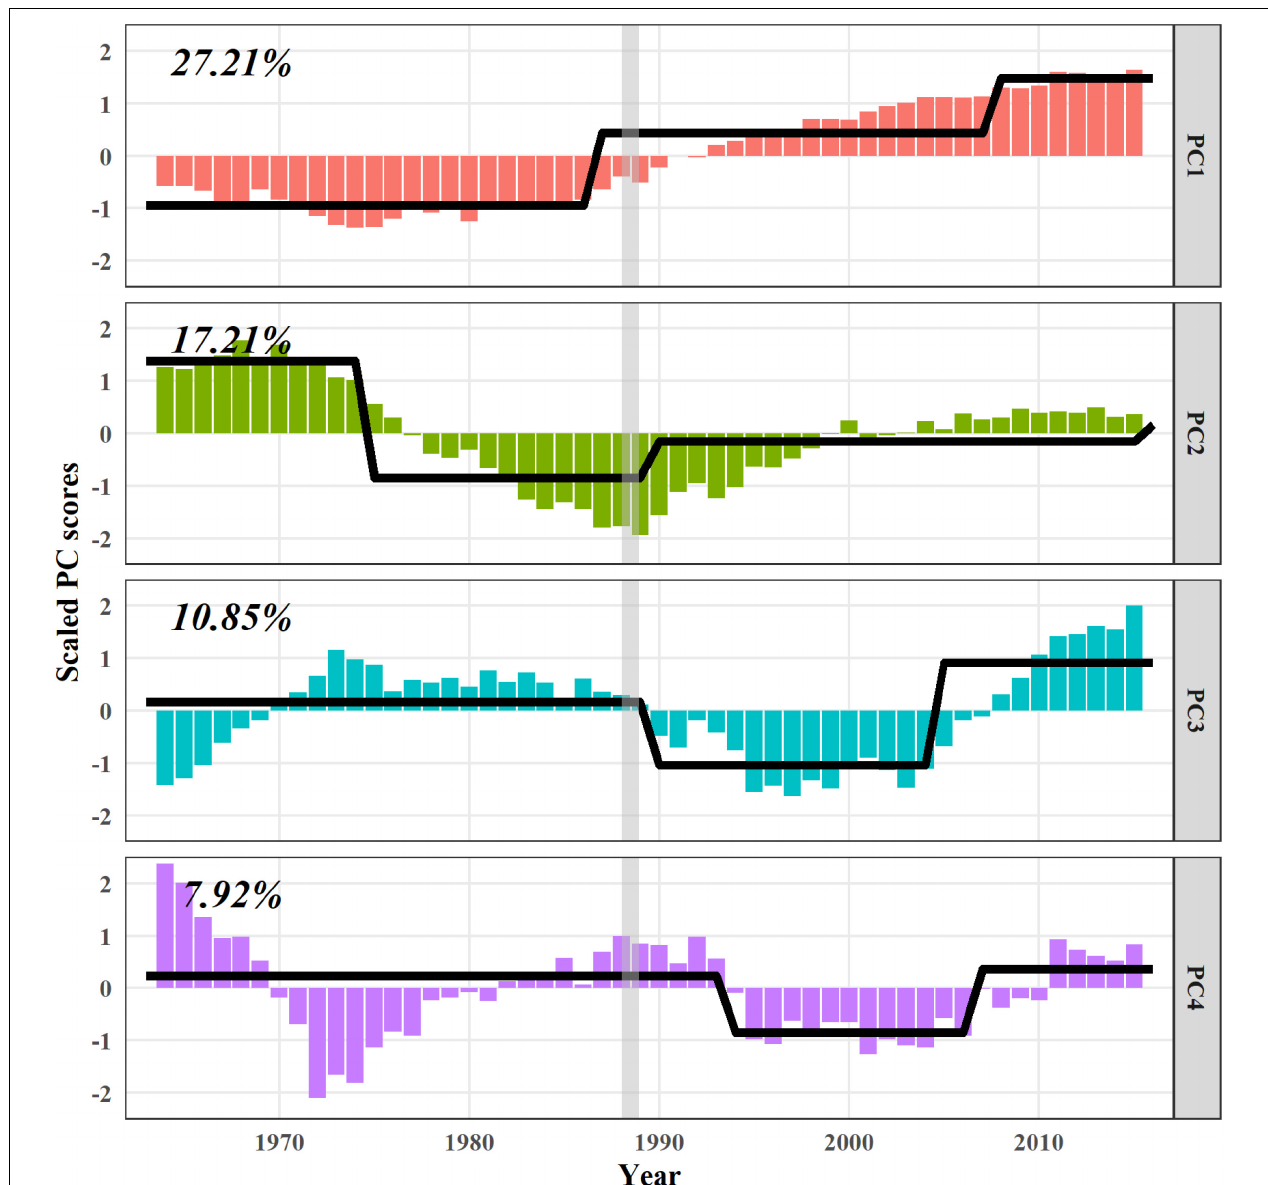
FIGURE 3 | Trajectories of the first four principal components (PCs). Numbers indicate the percentage of variance explained by each PC. Black lines represent regime means calculated by STARS, and gray lines represent the concentrated step-like changes in the late